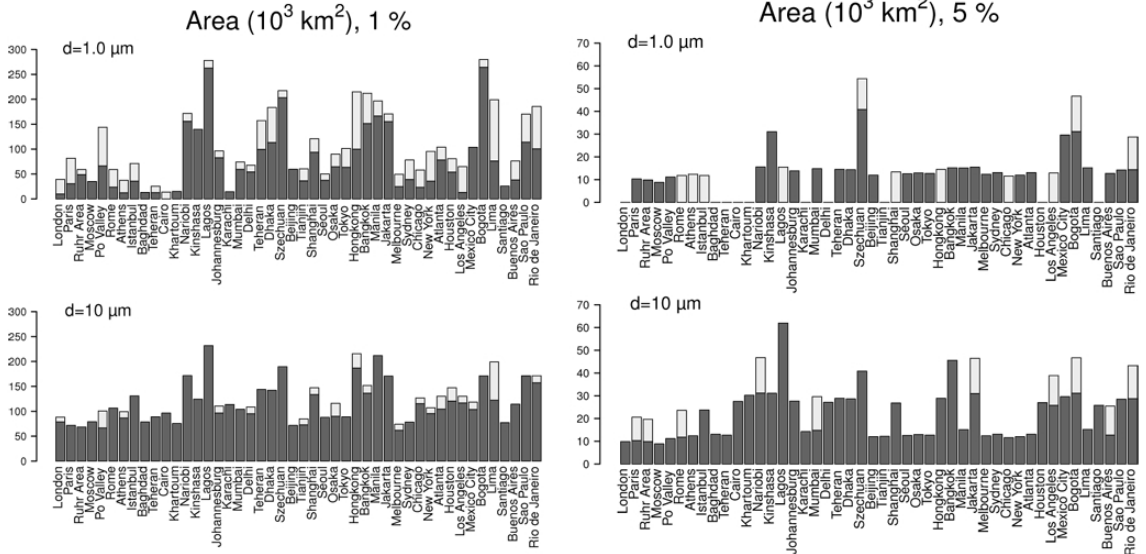
Fig. 5. Total area covered with more than 1% (left side) and 5% (right side) of the global mean annual emission. Top panels display the 1 . 0µm aerosol tracers, and bottom panels the 10 . 0µm aerosol tracers. The dark gray shaded bars show the minimum area covered by either the NS act or NS inact tracers, the light gray shaded bars on top the additional area covered by the tracers with the other nucleation scavenging state. Display order of the MPCs is by longitude, the area shown is in units of 10 3 km 2 .